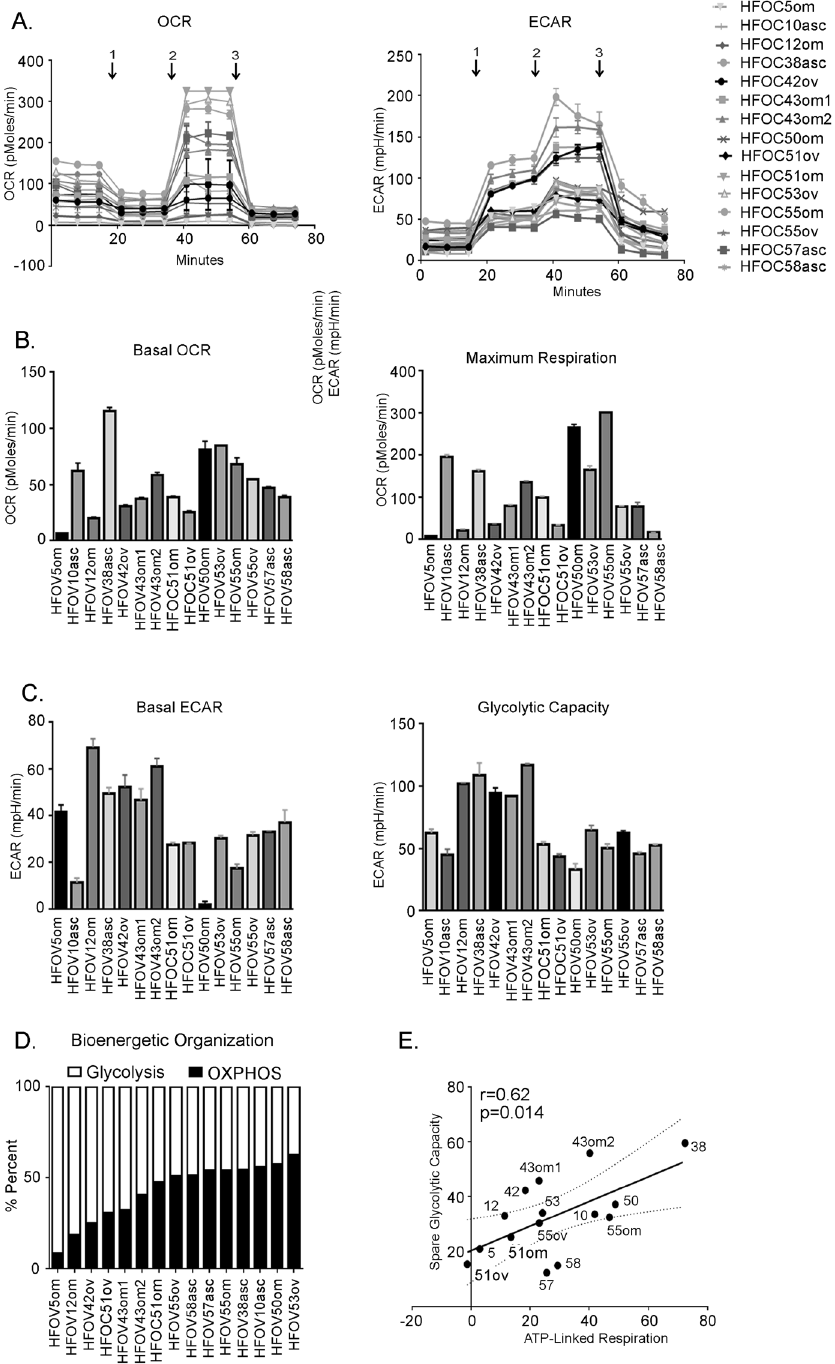
Figure 8. Profiling of patient derived ovarian cancer cells. Ovarian cancer cells were isolated from either tumor specimens or ascites samples of naïve patients diagnosed with ovarian cancer as described in the Materials and Methods. An equal number of cells were plated in multi-well Seahorse Biosciences XF96 plate (Boston, MA) and ( A ) oxygen consumption rate (OCR) and ECAR was measured under challenge by various metabolic regulators as described earlier. The ECAR profile injections were (1) glucose (fuel for glycolysis), (2) oligomycin (an ATP synthase blocker) and (3) 2DG (an inhibitor of glycolysis). OCR profile injections were (1) oligomycin (an ATP synthase inhibitor), (2) FCCP (an electron transport chain uncoupler) and (3) rotenone (an inhibitor of electron transport chain) injections. ( B ) Range of basal OCR and maximum capacity in the patient derived ovarian cancer cells. ( C ) Range of basal ECAR and glycolytic capacity in the patient derived ovarian cancer cells. ( D ) Ratio of basal ECAR and OCR represented as percent to represent the bioenergetic preference of a cell. ( E ) Positive correlation between ATP-linked respiration and spare glycolytic capacity. Seahorse experiments were replicated twice in triplicates. Abbreviations: ATP: adenosine triphosphatase; 2DG: 2-deoxyglucose; FCCP: carbonylcyanide-p- trifluoromethoxyphenyl hydrazine; OCR: Oxygen Consumption Rate; ECAR: Extracellular Acidification